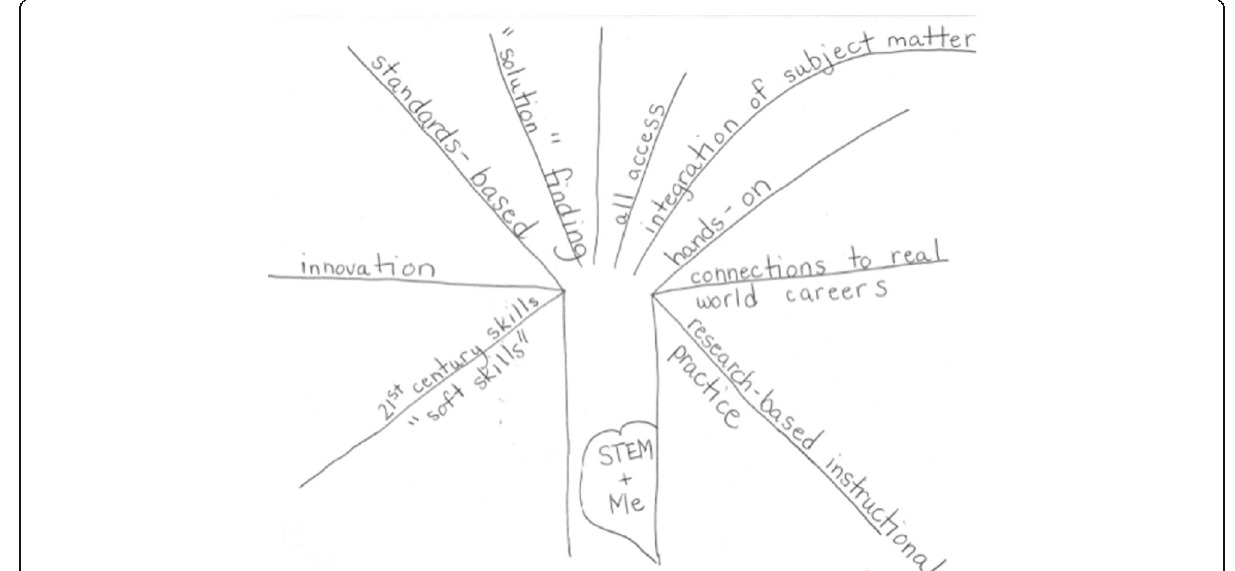
Fig. 3 Non-traditional concept map, Bridget, PD